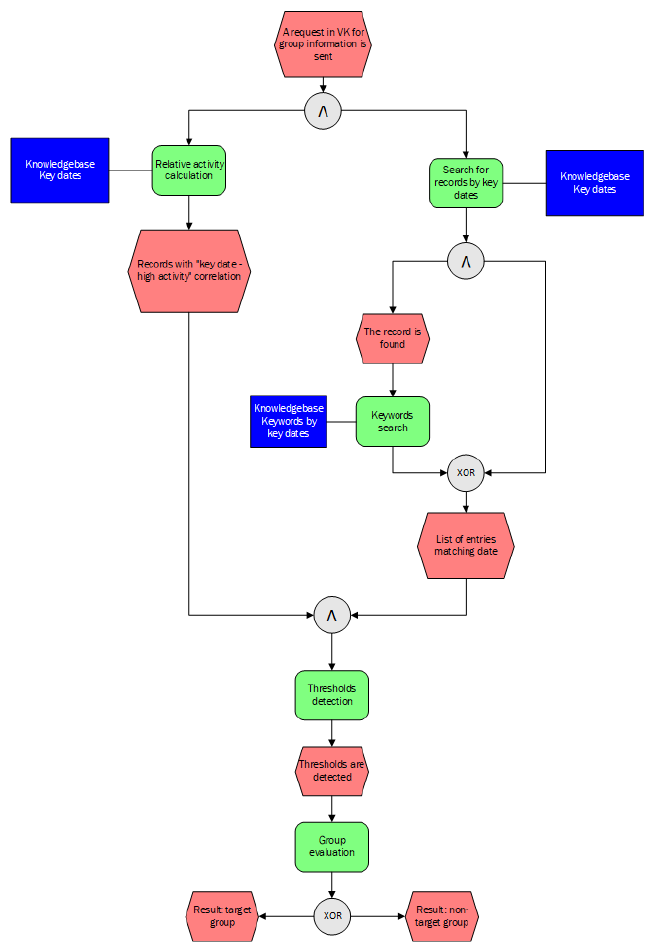
Figure A2. EPC diagram of the CCA algorithm.